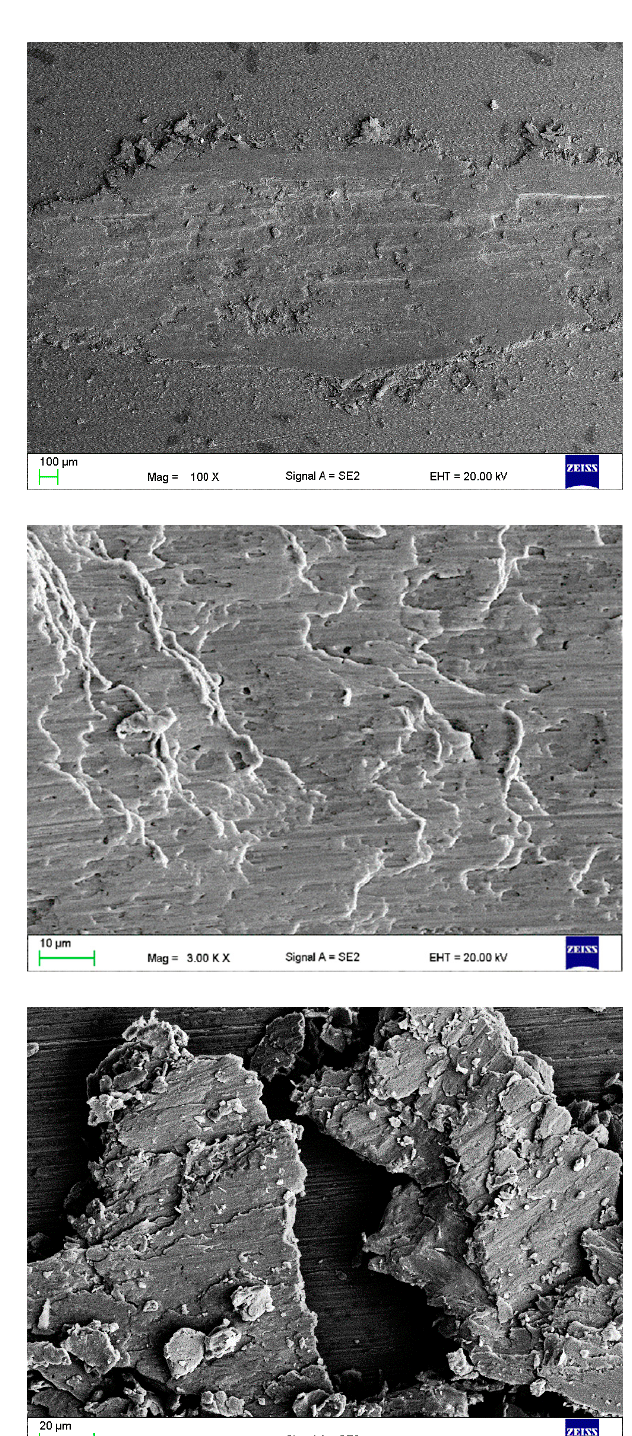
Figure 18. Wear track ( a , b ) of the tested CrAl v = 0.2 mm 3 /min layer and ( c ) wear debris. The influence of the powder feed rate during laser remelting on the depth of the wear trace is shown in Figure 19. It was found that the CrAl coating produced by laser remelting of the surface layer provides greater wear resistance. This is visible primarily at the smaller depth of the abrasion band for the Cu-ETP + CrAl layer for all manufacturing